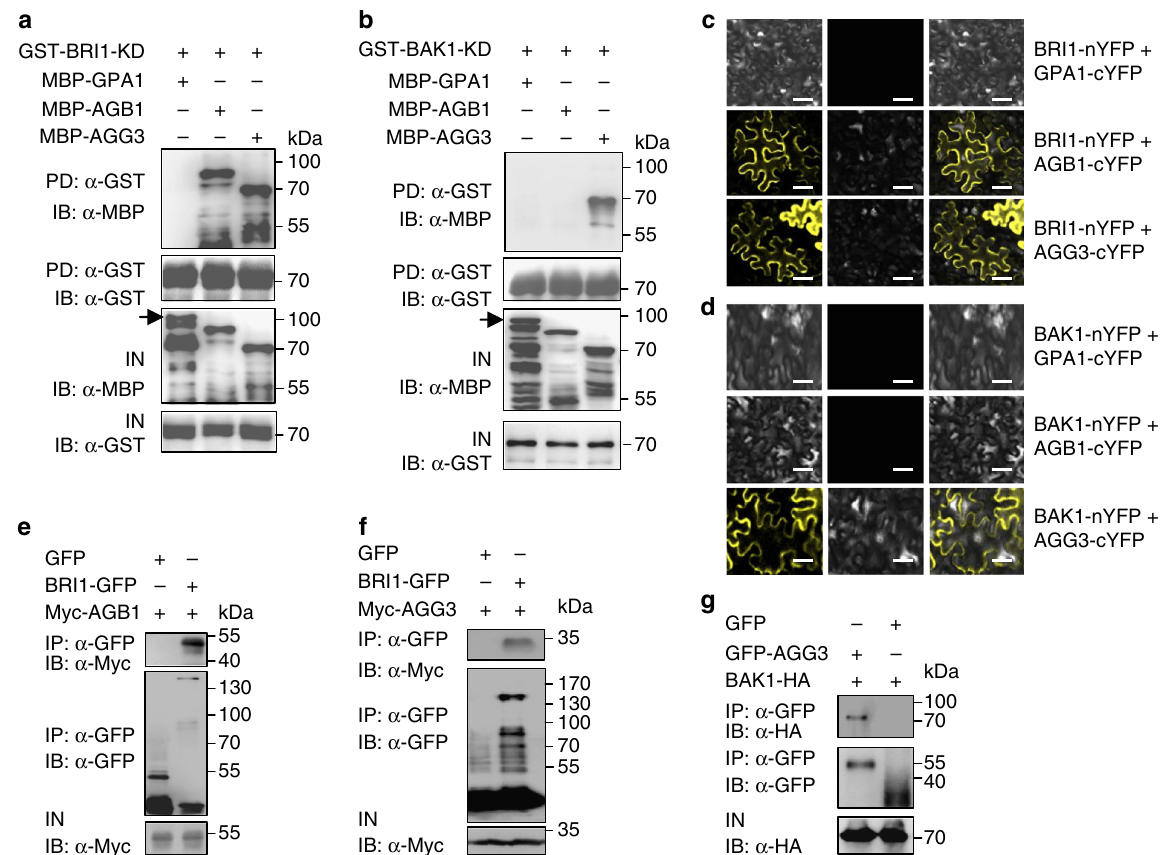
Fig. 4 BRI1 and BAK1 physically interact with G proteins. a BRI1 kinase domain (BRI1-KD) interacts with AGB1 and AGG3 in vitro. MBP-GPA1, MBP-AGB1, or MBP-AGG3 was pulled down by GST-BRI1-KD and detected by immunoblot with anti-MBP antibody. Arrow indicates the band of MBP-GPA1.IN, input; IB, immunoblot. b BAK1 kinase domain (BAK1-KD) interacts with AGG3 in vitro. MBP-GPA1, MBP-AGB1, or MBP-AGG3 was pulled down by GST-BAK1-KD and detected by immunoblot with anti-MBP antibody. Arrow indicates the band of MBP-GPA1. IN, input; IB immunoblot. c Bimolecular fl uorescence complementation (BiFC) assays show that BRI1 interacts with AGB1 and AGG3 in N . benthamiana leaves. BRI1-nYFP was coexpressed with GPA1-cYFP, AGB1-cYFP, or AGG3-cYFP in leaves of N . benthamiana . d BiFC assays show that BAK1 interacts with AGG3 in N . benthamiana leaves. BAK1-nYFP was coexpressed with GPA1-cYFP, AGB1-cYFP, or AGG3-cYFP in leaves of N . benthamiana . e BRI1 interacts with AGB1 in Arabidopsis. The extracted total proteins from 35S:GFP ; 35S:Myc-AGB1 , or pBRI1:BRI1-GFP ; 35S:Myc-AGB1 seedlings were incubated with GFP-Trap-A, respectively. Immunoprecipitates were examined using anti-Myc and anti-GFP antibodies, respectively. IP immunoprecipitation; IN input; IB immunoblot. f BRI1 interacts with AGG3 in Arabidopsis. The extracted total proteins from pBRI1:BRI1-GFP ; 35S:GFP or pBRI1:BRI1-GFP ; 35S:Myc-AGG3 seedlings were incubated with GFP-Trap-A, and examined using anti-Myc and anti-GFP antibodies, respectively. IP immunoprecipitation; IN input; IB immunoblot. g BAK1 interacts with AGG3